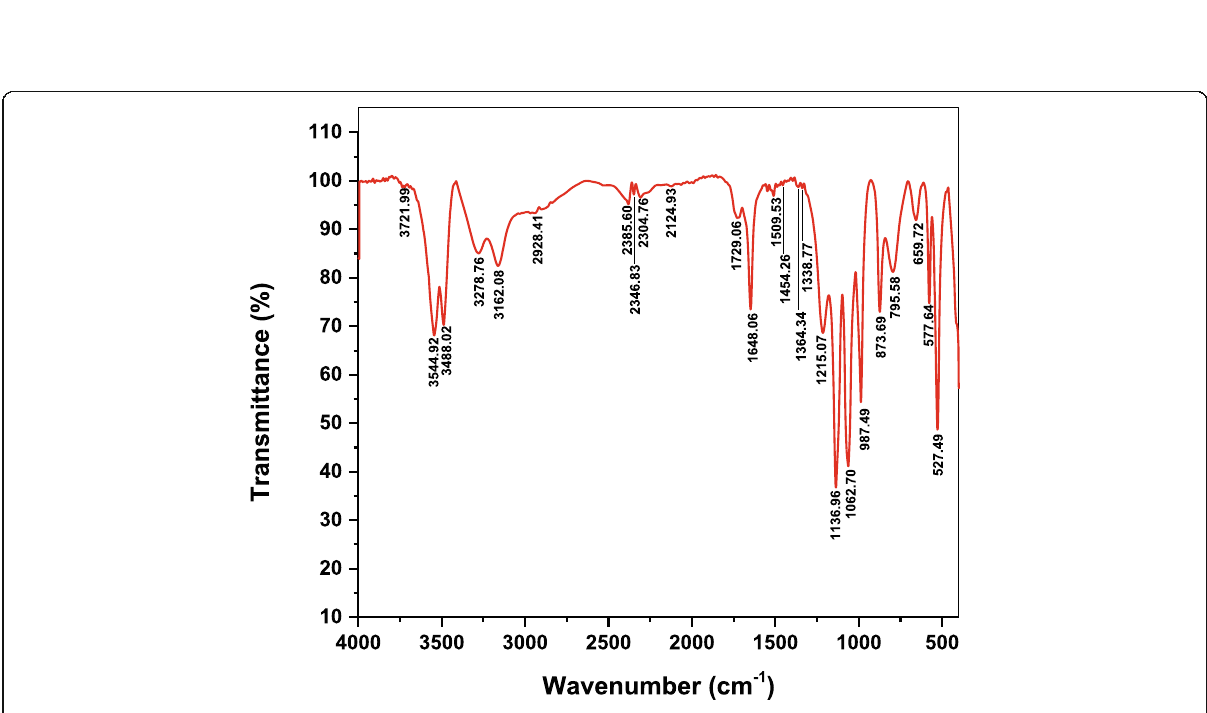
Fig. 8 FTIR spectrum of 50 mg A. marmelos added CHPD